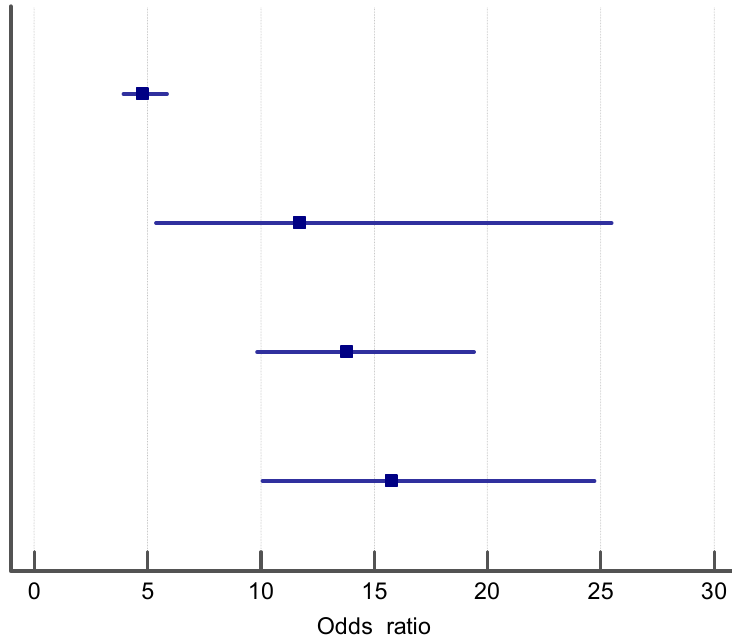
Figure 2. The estimated odds ratio for the association of psychological distress and FD in each control group.